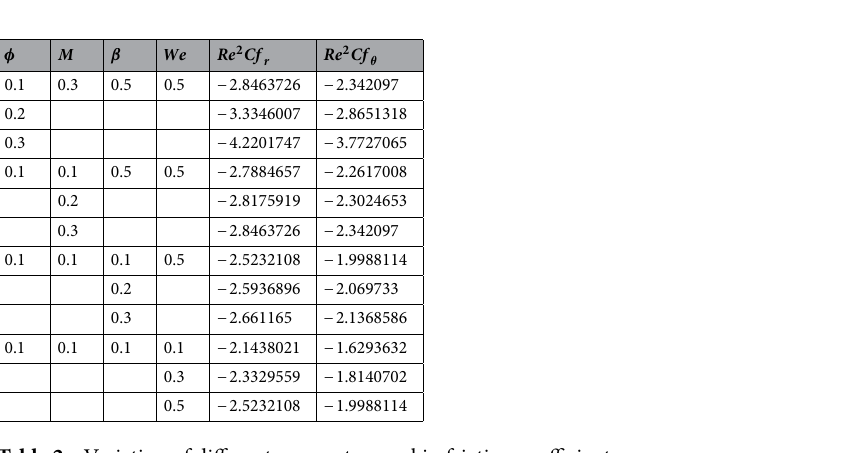
Table 2. Variation of different parameter on skin friction